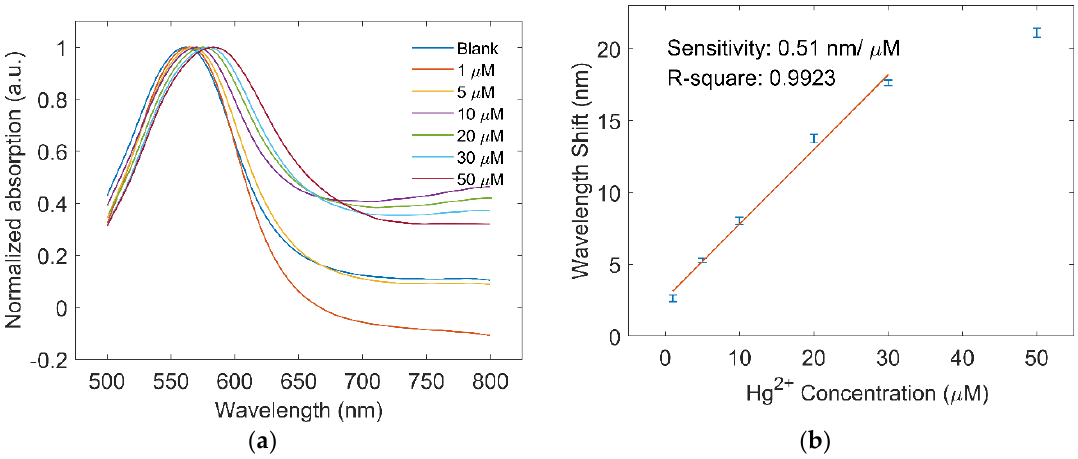
Figure 6. Hg 2+ detection based on the proposed LSPR sensor. ( a ) Normalized LSPR spectra of different concentrations of Hg 2+ solution; ( b ) LSPR peak wavelength as a function of the concentrations of Hg 2+ solution.